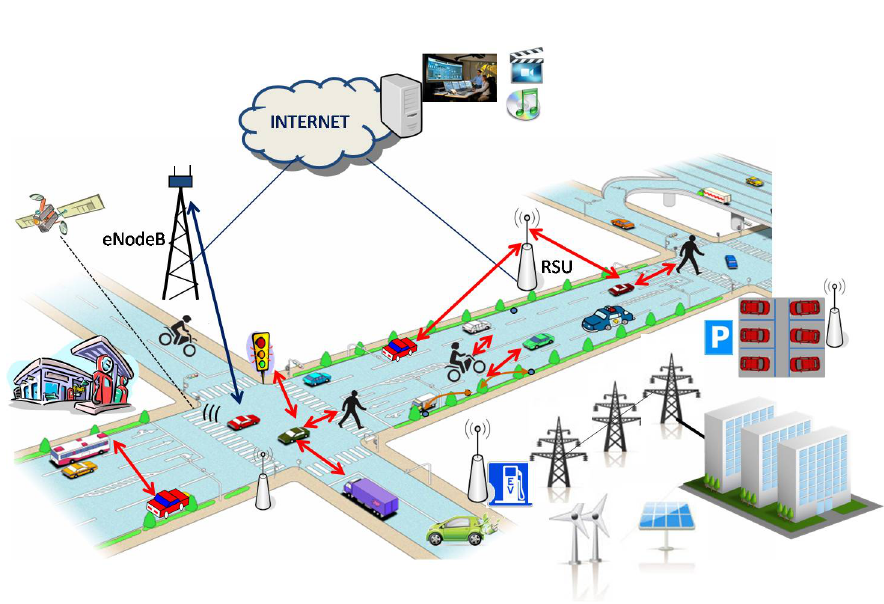
Figure 1. The Internet of Vehicles